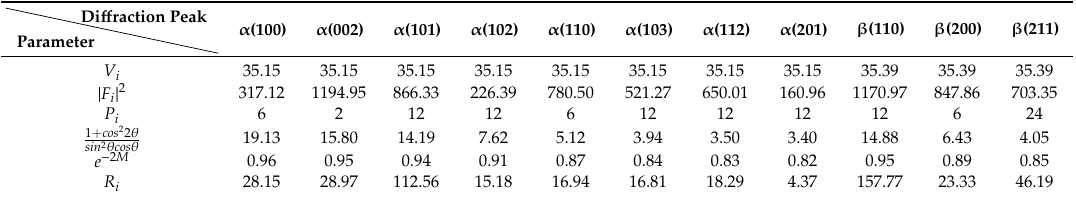
Table 2. The values of the parameters V i , | F i | 2 , P i , 1 + cos 2 2 for 4 h after being solution-treated at 850 ◦